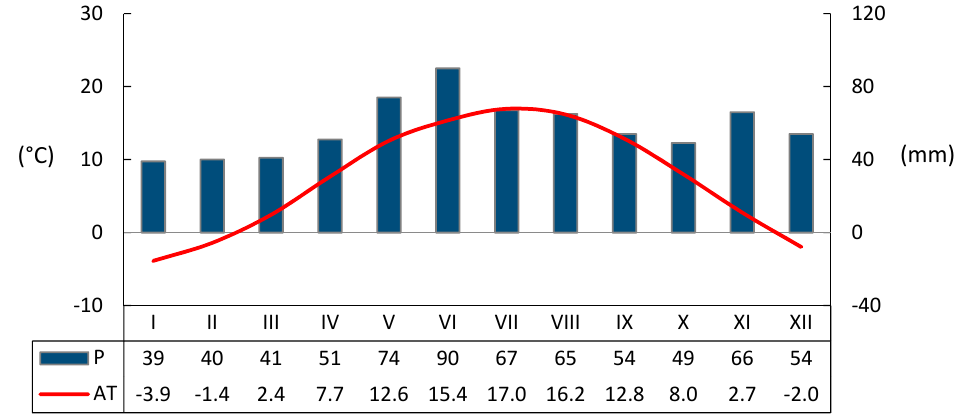
Figure 3. Monthly averages (normals) of mean air temperature ( AT , ◦ C) and precipitation totals ( P , mm) for the Bienska dolina area, calculated based on reference period 1961–1990 data (January–December; in Roman numerals I–XII).